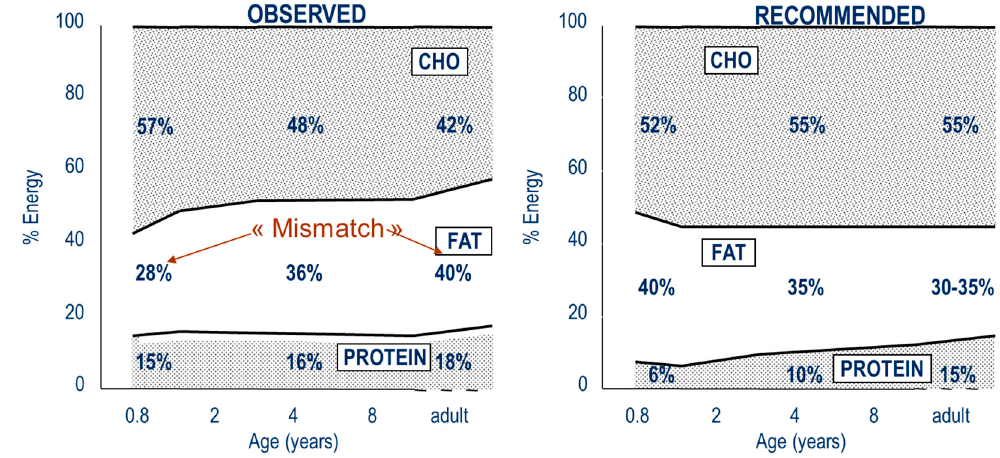
Figure 3. Actual nutrient consumption according to age (ELANCE Study) [11], and recommended intakes.